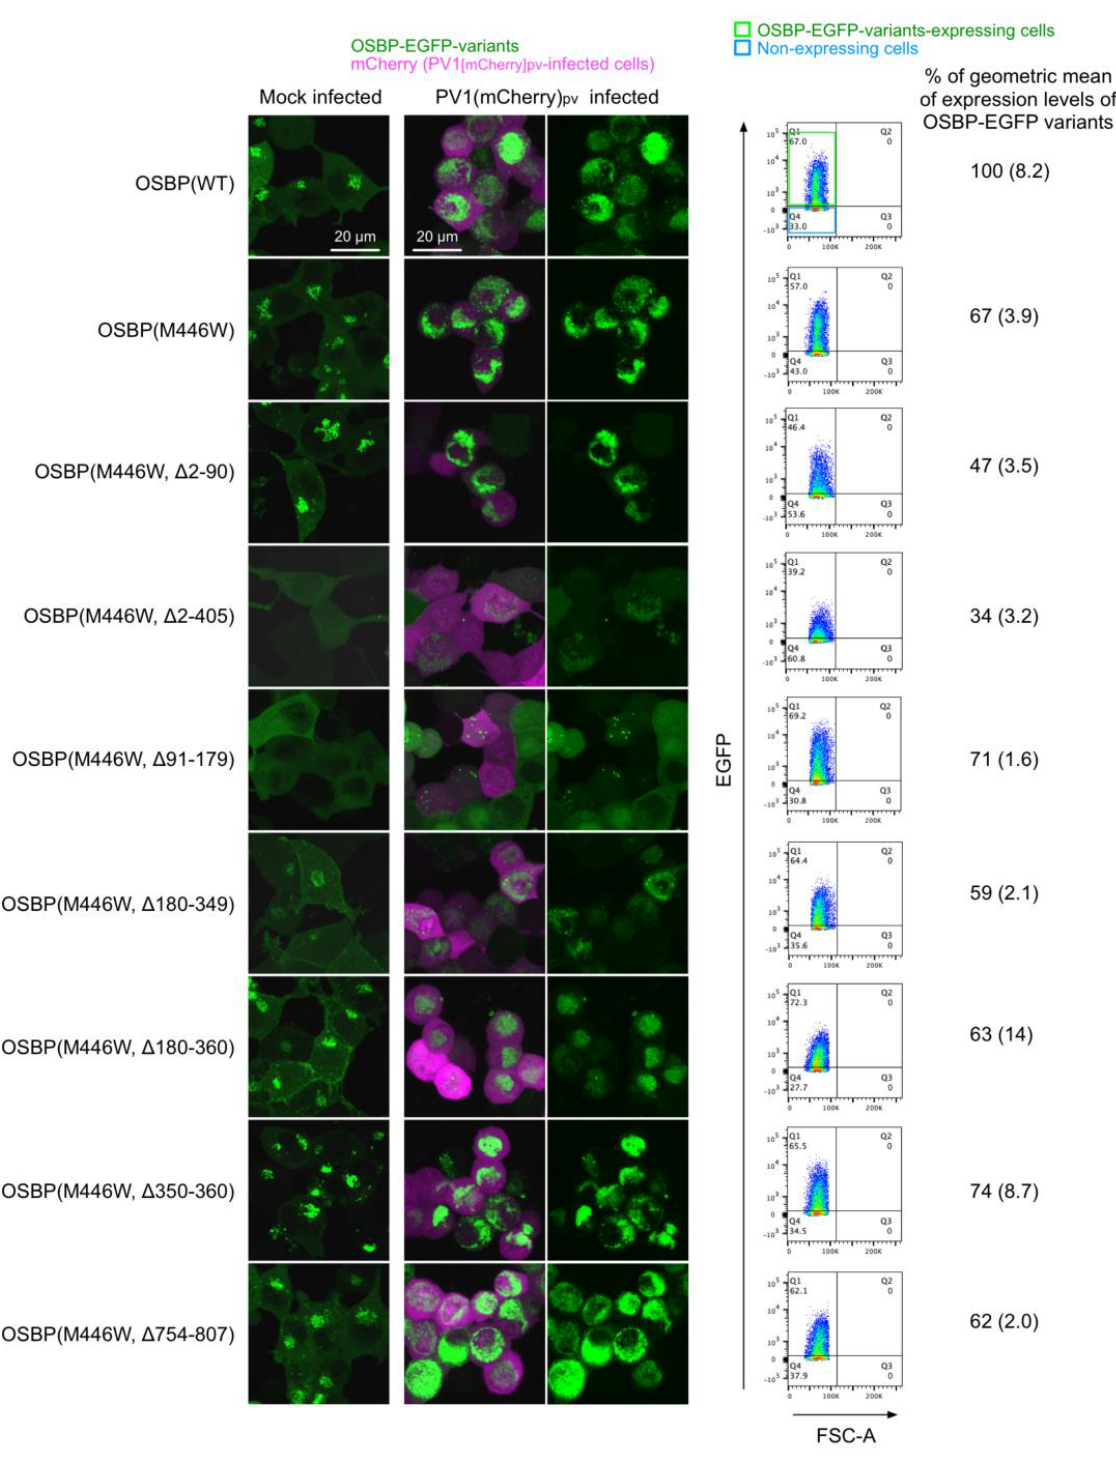
Figure 2. Subcellular localization and expression levels of the OSBP variants. ( Left ) Maximum projection view of HEK293 cells expressing the OSBP variants analyzed by confocal microscopy. The cells were infected with PV1(mCherry) pv at an MOI of 50 at 37 ◦ C for 5 h. Images of the representative cells (mock-infected or PV1(mCherry) pv -infected cells) at 5 h p.i. are shown. ( Right ) Expression levels of the OSBP variants. The cells were analyzed by flow cytometry. The expression level of OSBP-EGFP(WT)-expressing cells is taken as 100%. The data are representative of two independent experiments with two or three biological replicates.